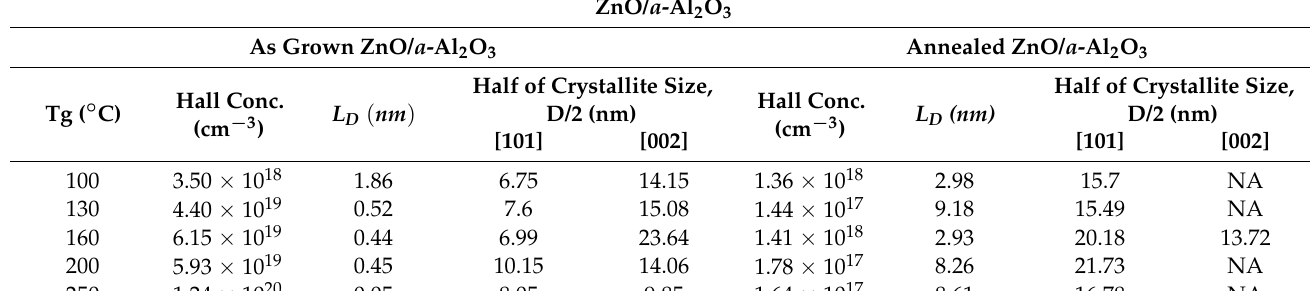
Table 5. Approximate values of the Debye length and a half of the crystallite size for different carrier concentration for as grown and annealed samples of thin ZnO films on a -Al 2 O 3 (top) and Si (bottom). ZnO/ a -Al 2 O 3 As Grown ZnO/ a -Al 2 O